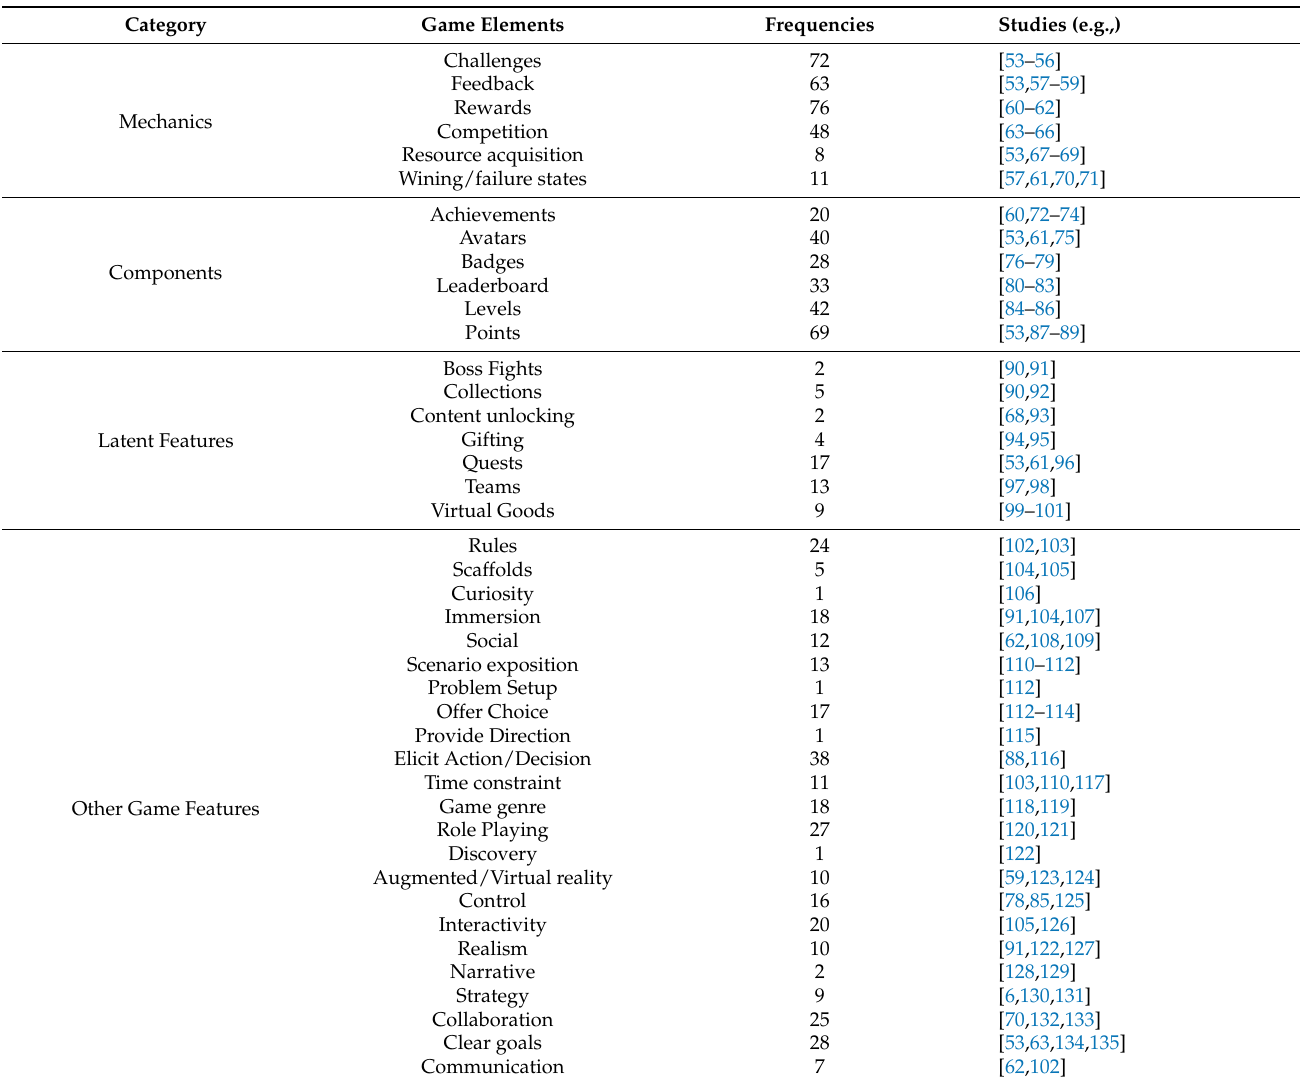
Table 1. Classification of game elements and their frequencies in BCG studies.